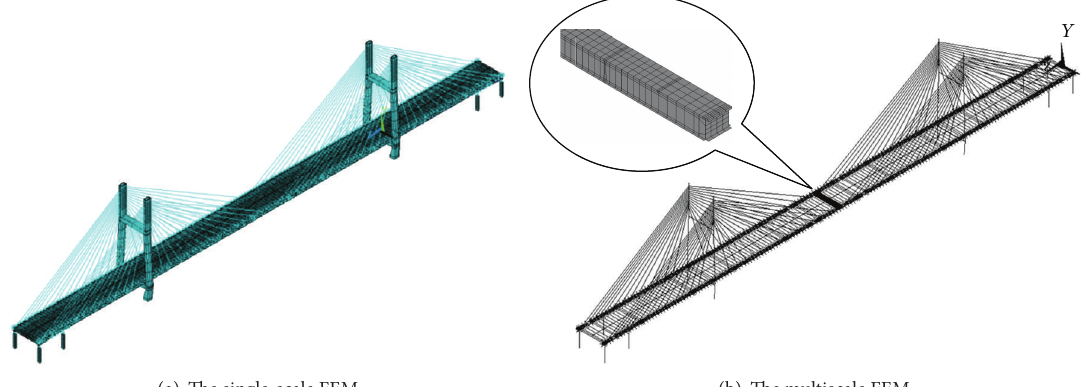
Figure 6: The multiscale FE model of Guanhe Bridge.